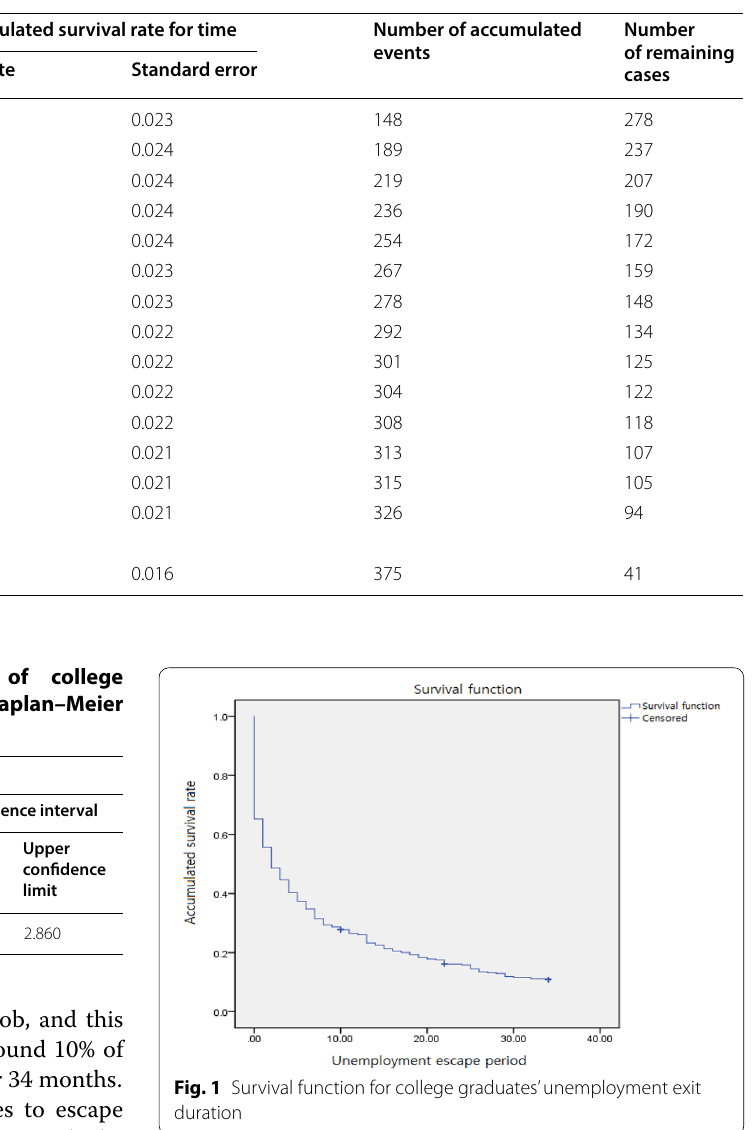
Table 4 Survival rate for each unemployment exit duration